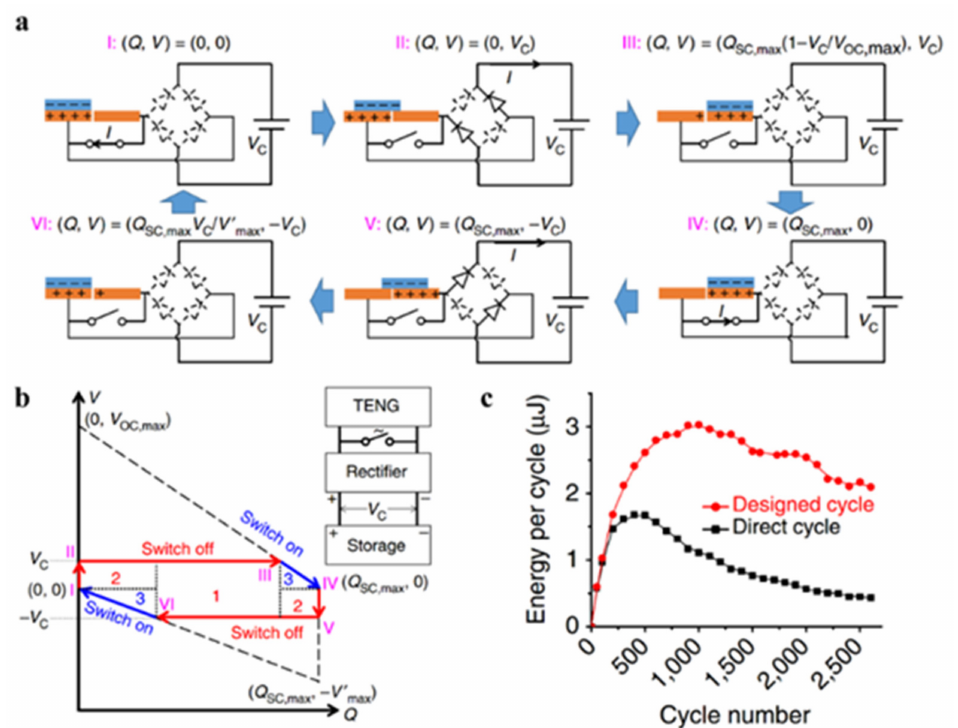
Figure 4. Power management with parallel travel switch. ( a ) Electrical connection and closing position of the parallel travel switch. ( b ) V - Q curve of the charging circuit with the switch. ( c ) The dependence of energy per cycle-on-cycle number with/without management. Reproduced with permission [70]. Copyright 2016, Nature